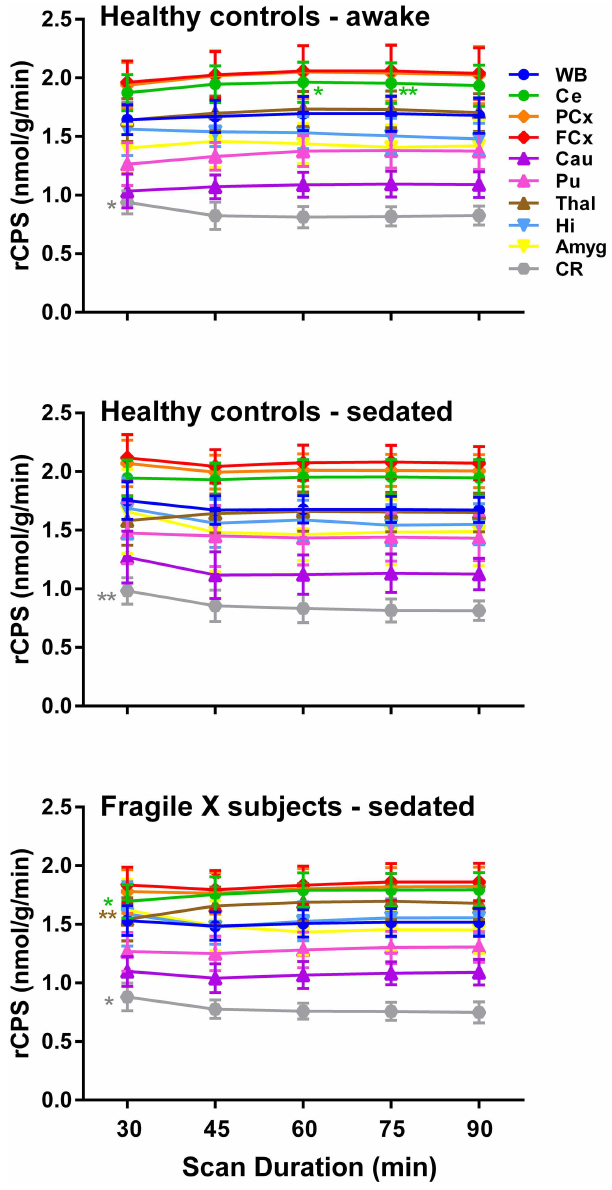
Fig 2. rCPS estimated over the interval beginning at the time of injection and ending 30, 45, 60, 75, or 90 min later. The Basis Function Method was used to estimate the rate constants of the homogeneous tissue kinetic model, rCPS was computed for each voxel in the brain, and ROI values were obtained by averaging values over all voxels in the ROI. The following regions were evaluated: whole brain (WB), cerebellum (Ce), frontal cortex (FCx), parietal cortex (PCx), thalamus (Thal), caudate (Cau), putamen (Pu), amygdala (Amyg), and hippocampus (Hi). Points represent means ± SD for 12 healthy control subjects studied awake, 12 healthy control subjects studied sedated, and 15 FrX subjects studied sedated. Estimates of each parameter were analyzed for statistically significant effects by means of RM ANOVA with region and scan duration as within subjects variables. Awake healthy control group : Interaction between region and scan duration was statistically significant (F 7.9,87.2 = 3.82, P = 0.001). Post-hoc paired comparisons between the estimates at a 90 min scan duration with all other scan durations for each region are indicated on the figure. (cid:3) , P (cid:20) 0.05; (cid:3)(cid:3) , P (cid:20) 0.01. Propofol-sedated healthy control group : Interaction between region and scan duration was statistically significant (F 6.3,69.0 = 2.37, P = 0.036). Post-hoc paired comparisons between the estimates at a 90 min scan duration with all other scan durations for each region are indicated on the figure. (cid:3) , P (cid:20) 0.05; (cid:3)(cid:3) , P (cid:20) 0.01. Propofol-sedated subjects with FXS : Interaction between region and scan duration was statistically significant (F 9.3,130.6 = 4.78, P < 0.001). Post-hoc paired comparisons between the estimates at a 90 min scan duration with all other scan durations for each region are indicated on the figure. (cid:3) , P (cid:20) 0.05; (cid:3)(cid:3) , P (cid:20) 0.01.